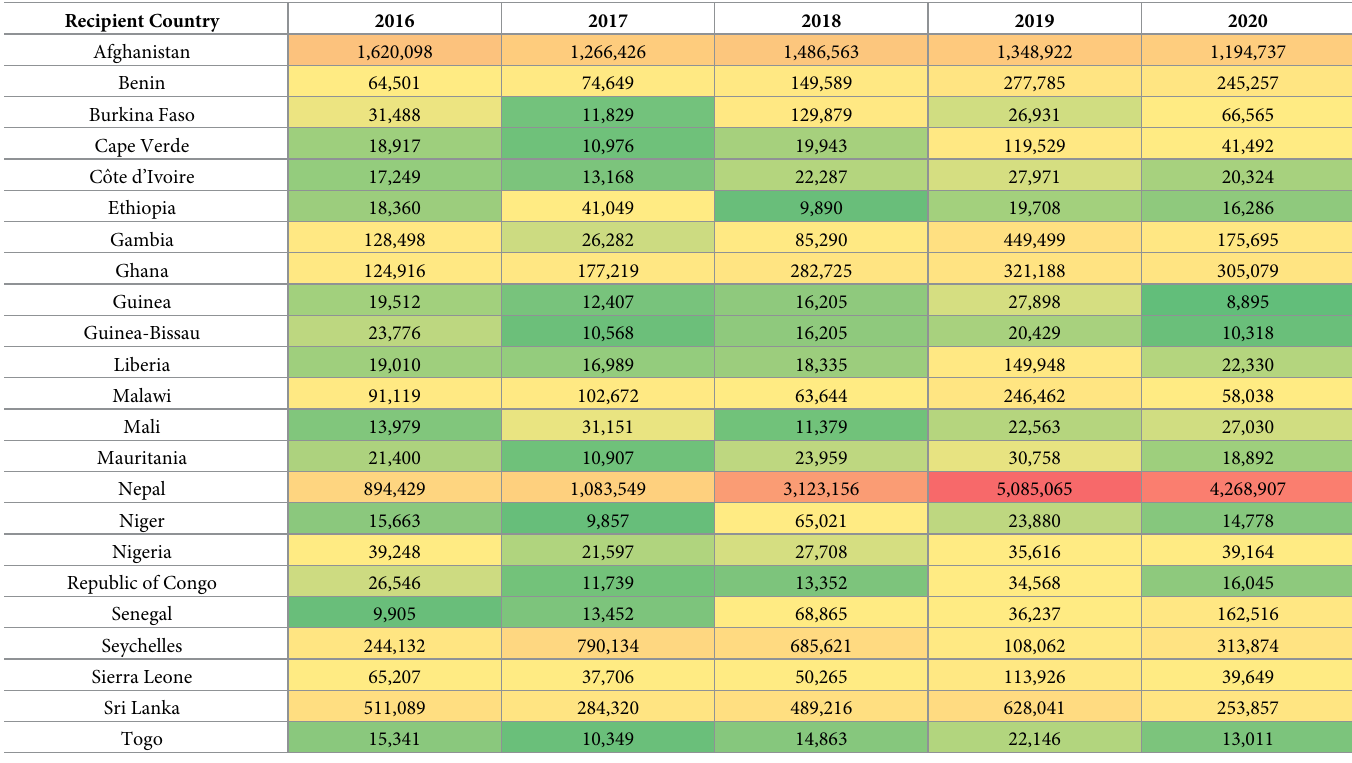
Table 4. Estimated annual DAH (USD) contributed by India disaggregated by year and select recipient countries (2016–2020). Red and green represent high and low contributions to the recipient country, respectively. Recipient